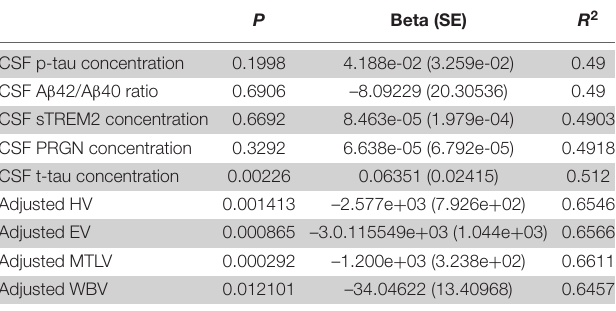
TABLE 3 | Correlations of baseline CSF p-tau, t-tau, A β 42/A β 40 ratio, sTREM2, PRGN, and brain volumes (segmented in 3.0 T MRI) with cognitive status (measured by ADAS13) in subjects with cognition impairment.